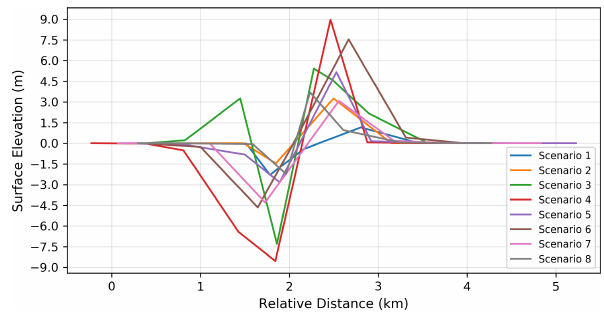
Figure 7. Initial tsunami wave heights for the eight submarine land- slide scenarios with the X axis is towards offshore to the